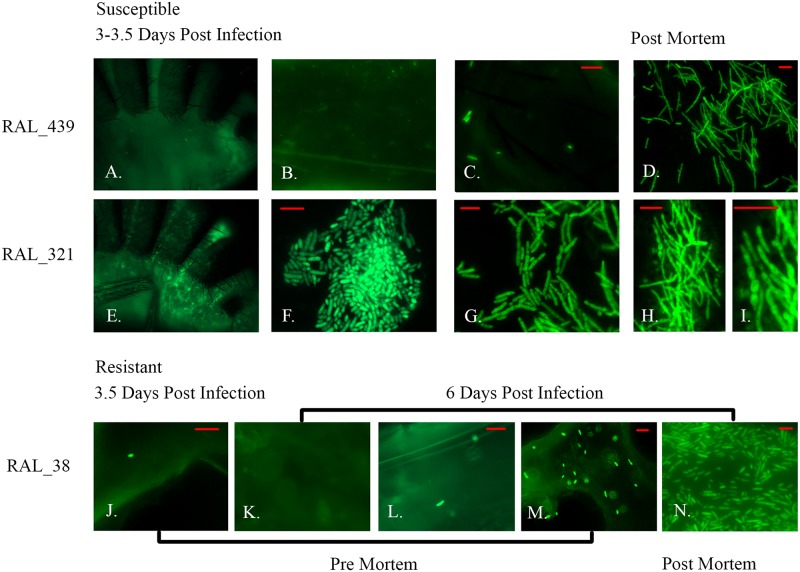
Growth of GFP-expressing Ma549 can be visualized in DGRP flies.DGRP fly lines RAL_439, RAL_321 and RAL_38 photographed at different time points post infection with Ma549-GFP. A) No visible growth of Ma549-GFP in a living RAL_439 fly’s abdomen, and there are very few pre-mortem fungal propagules in squashed RAL_439 flies (B-C). Ma549-GFP only proliferates in RAL_439 post mortem (D). In contrast, Ma549-GFP blastospores and short hyphal lengths are visible in the hemocoele from outside a still living RAL_321 fly’s abdomen (E), and in pre- and post-mortem squash preparations (F to I). Variation among individual flies in resistant line RAL_38 in number of Ma549-GFP propagules per fly 6 days’ post-infection (J-N). At death, Ma549-GFP blastospores and short hyphal lengths are found in hemocoele of all DGRP lines (D, H, I and N). The pictures are representative of the 10 flies per line per time point examined for the experiment. Bars in images represent 20 μm.